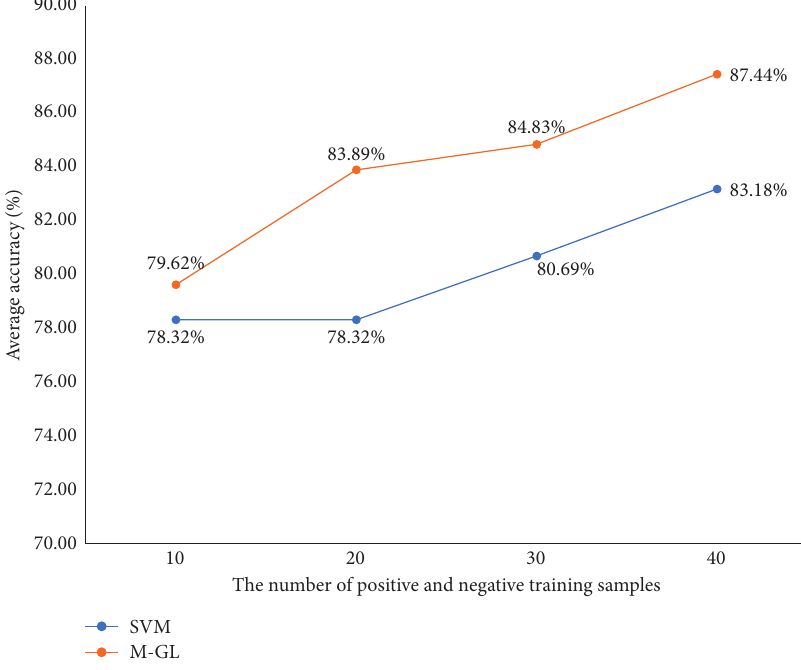
Figure 4: Variations of average accuracy with the increased number of labeled samples for